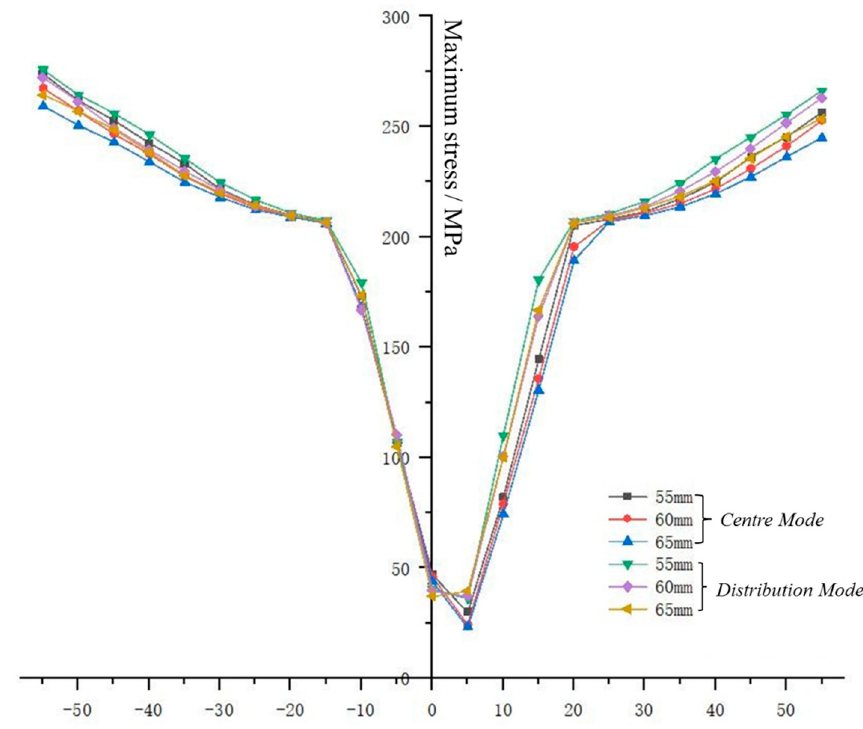
Figure 9. Maximum stress–temperature curve of bellows with different wave heights.